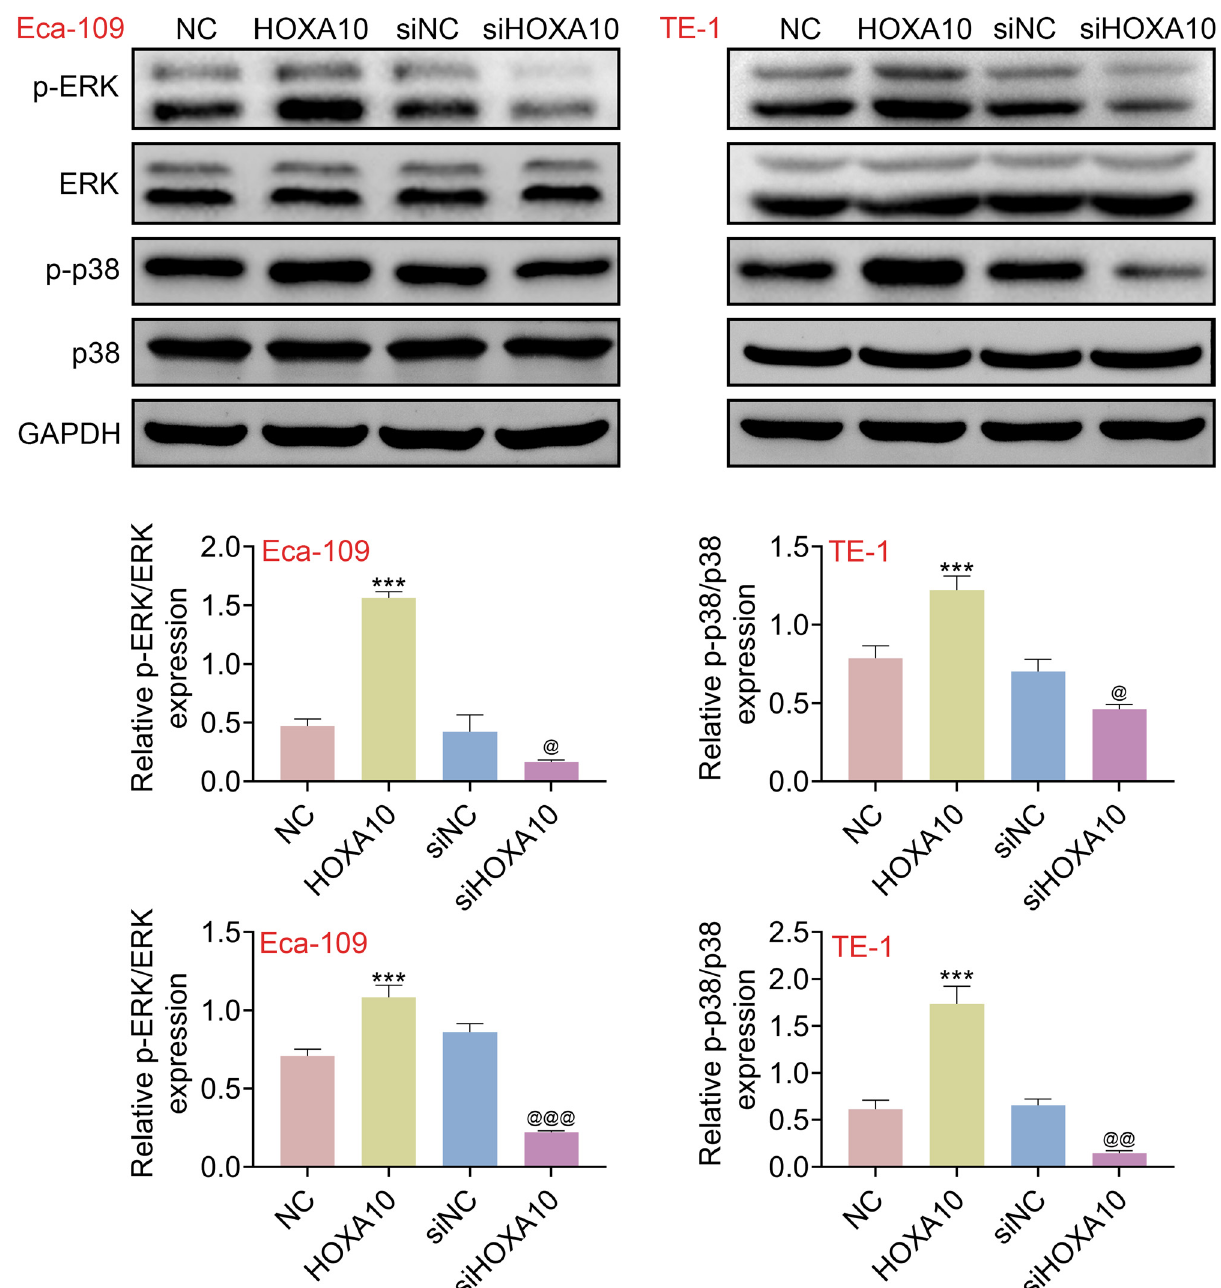
Figure 4: HOXA10 activated p38/ERK signaling pathway in EC cells. After transfected with oe - HOXA10 or siHOXA10, the p - ERK, ERK, p - P38, and P38 expressions were detected by western blot in Eca - 109 and TE - 1 cells. Each experiment repeated three times. *** p < 0 .001 vs NC. @ p < 0.05, @@ p < 0.01, @@@ p < 0.001 vs